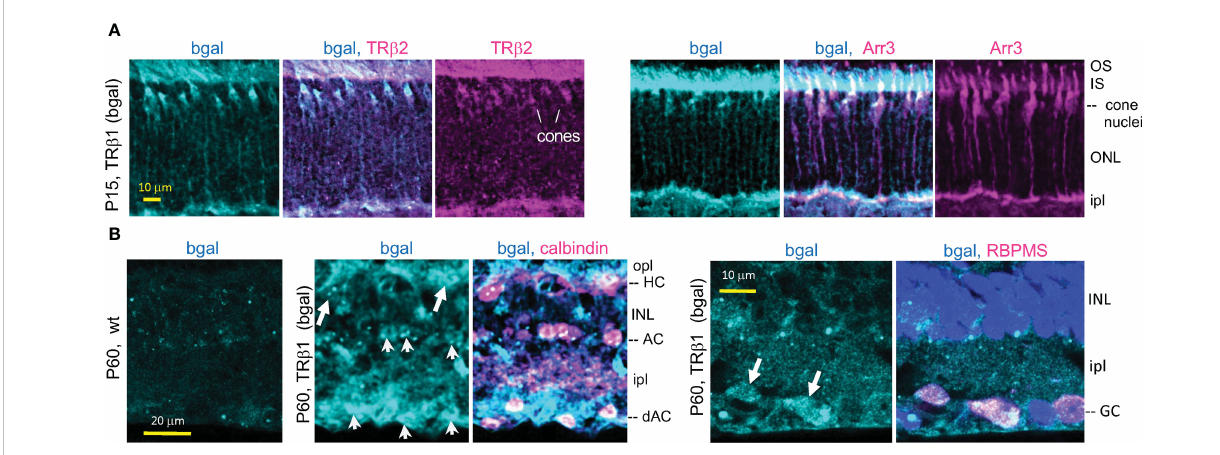
FIGURE 4 TR b 1 localization in cones and inner retinal neurons detected in Thrb b1 lacZ reporter mice. (A) , TR b 1 ( b -galactosidase, bgal protein immuno fl uorescence) co-staining with cone markers (TR b 2, Arr3) in Thrb +/ b1 mice. (B) , TR b 1 (bgal) in amacrine (arrowheads) and horizontal cells (arrows) shown by staining for calbindin ( left ). Staining was sometimes weak and appeared punctate. TR b 1 was also detected in ganglion cells (arrowheads) by staining for RBPMS ( right ). In panel (B) , Thrb b1/b1 homozygotes were analyzed to enhance detection of bgal. For RBPMS, a general nuclear stain (DAPI, blue) shows tissue background. AC, amacrine cell; dAC, displaced AC; GC, ganglion cell; HC, horizontal cell; INL, inner nuclear layer; ipl, inner plexiform layer; IS/OS, inner/outer segments; ONL, outer nuclear layer; opl, outer plexiform